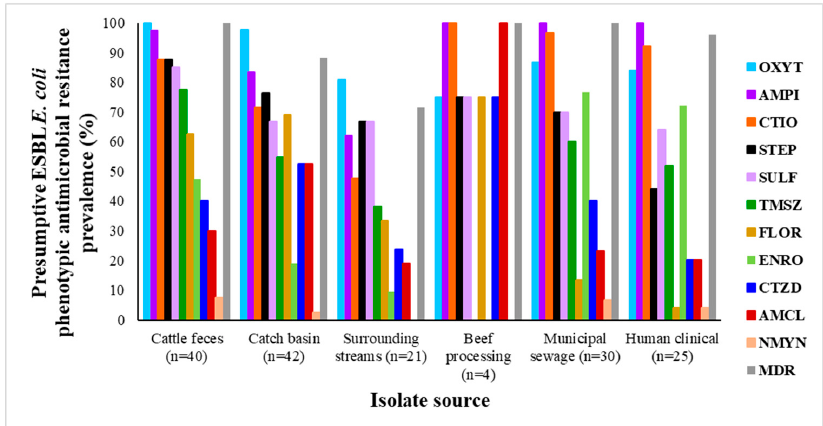
Figure 1. Phenotypic antimicrobial resistance profiles of presumptive extended-spectrum β -lactamase (ESBL) E. coli obtained from different sources as described in materials and methods.